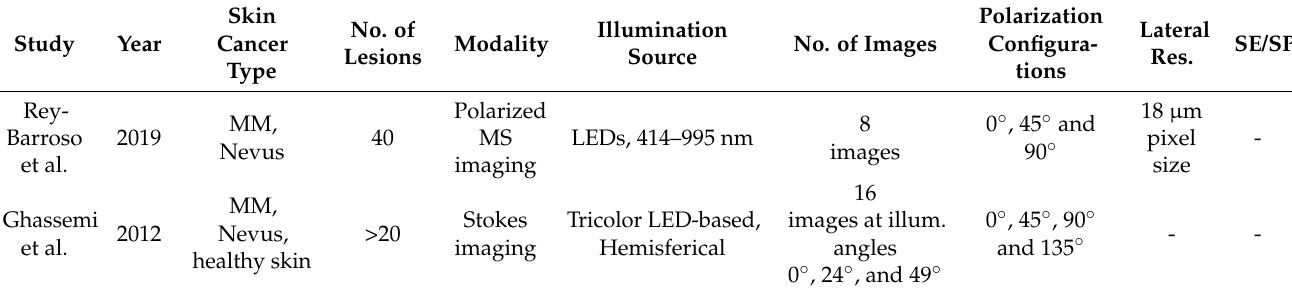
Table 5. Contributions of polarimetric imaging to skin cancer